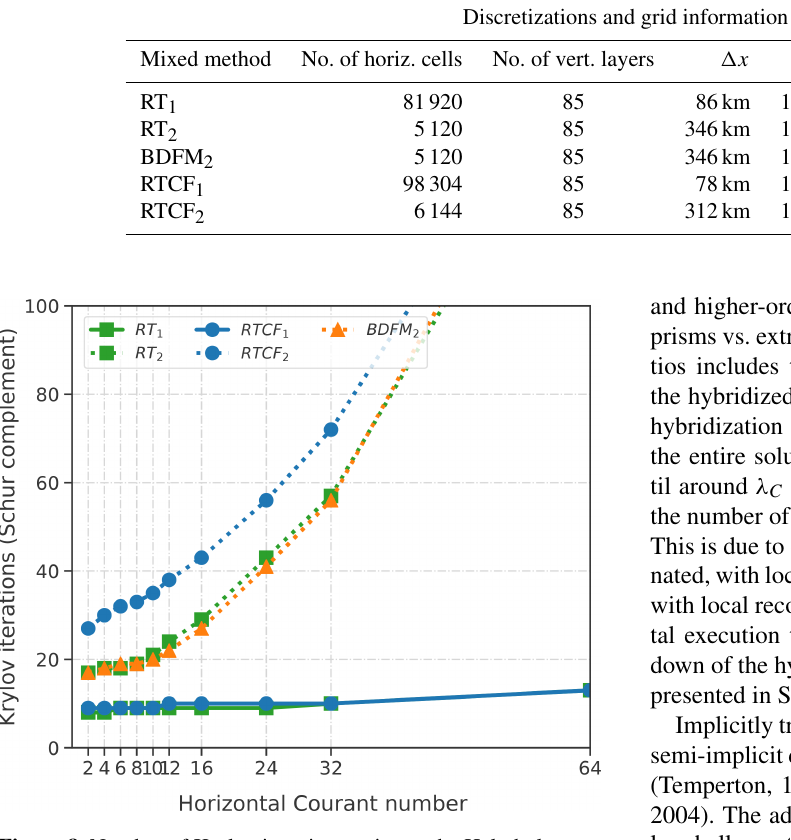
Figure 8. Number of Krylov iterations to invert the Helmholtz sys- tem using (cid:101) H − 1 as a preconditioner. The preconditioner is applied using a direct LU factorization within a GMRES method on the en- tire pressure equation. While the lowest-order methods grow slowly over the Courant number range, the higher-order (by only 1 approx- imation order) methods quickly degrade and diverge after the criti- cal range λ C = O ( 2 ) – O ( 10 ) . At λ C > 32, the solvers take over 150